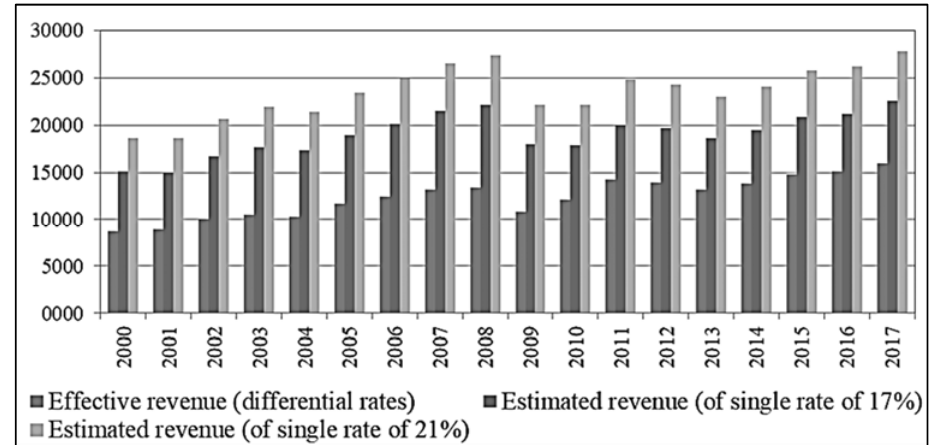
Figure 1. Effective VAT revenue with differentiated rates and estimated VAT revenues with a single rate of 17% and 21% (in M€). Source: Own